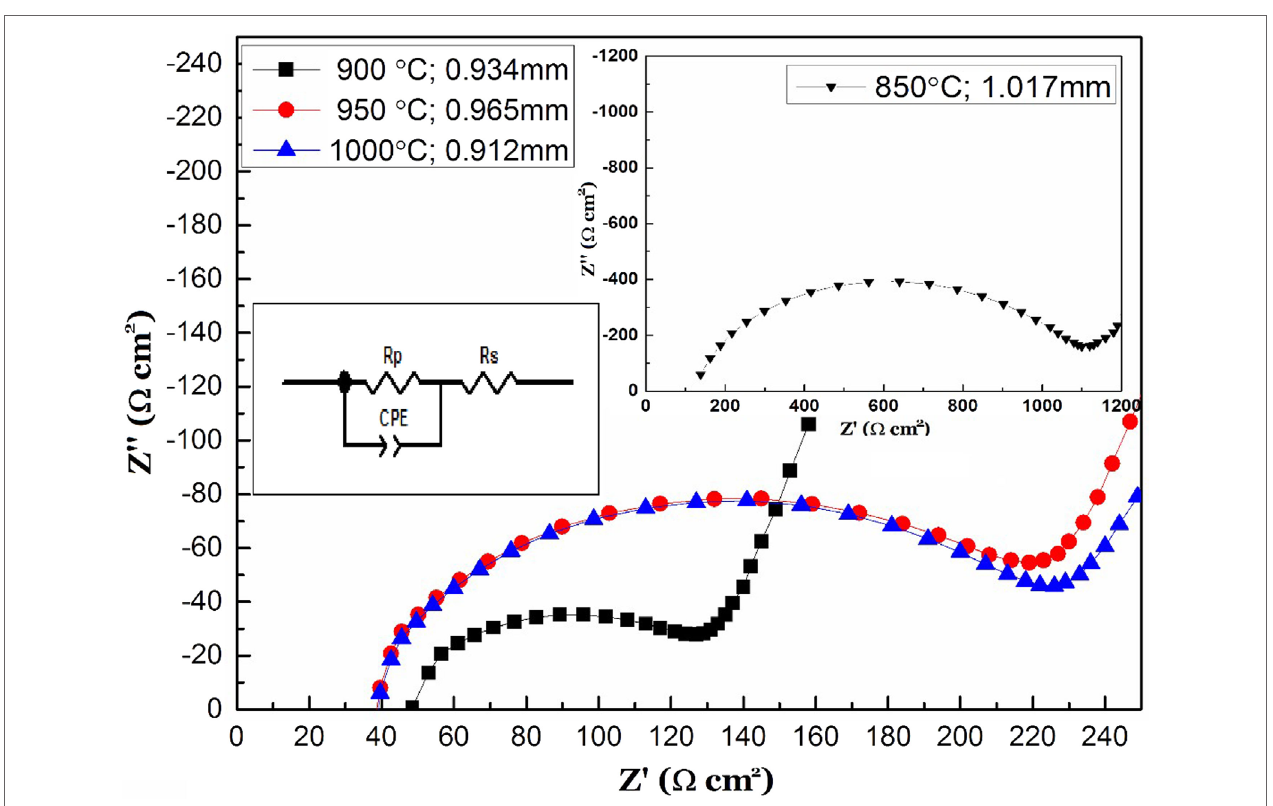
FigUre 3 | impedance profiles of au/li 1.5 al 0.5 ge 0.2 Ti 1.3 (PO 4 ) 3 /au as a function of the sintering temperature . FigUre 4 | XrD patterns of li 1 + x al x ge 0.2 Ti 1.8 − x (PO 4 ) 3 sintered at 900°c as a function of x .